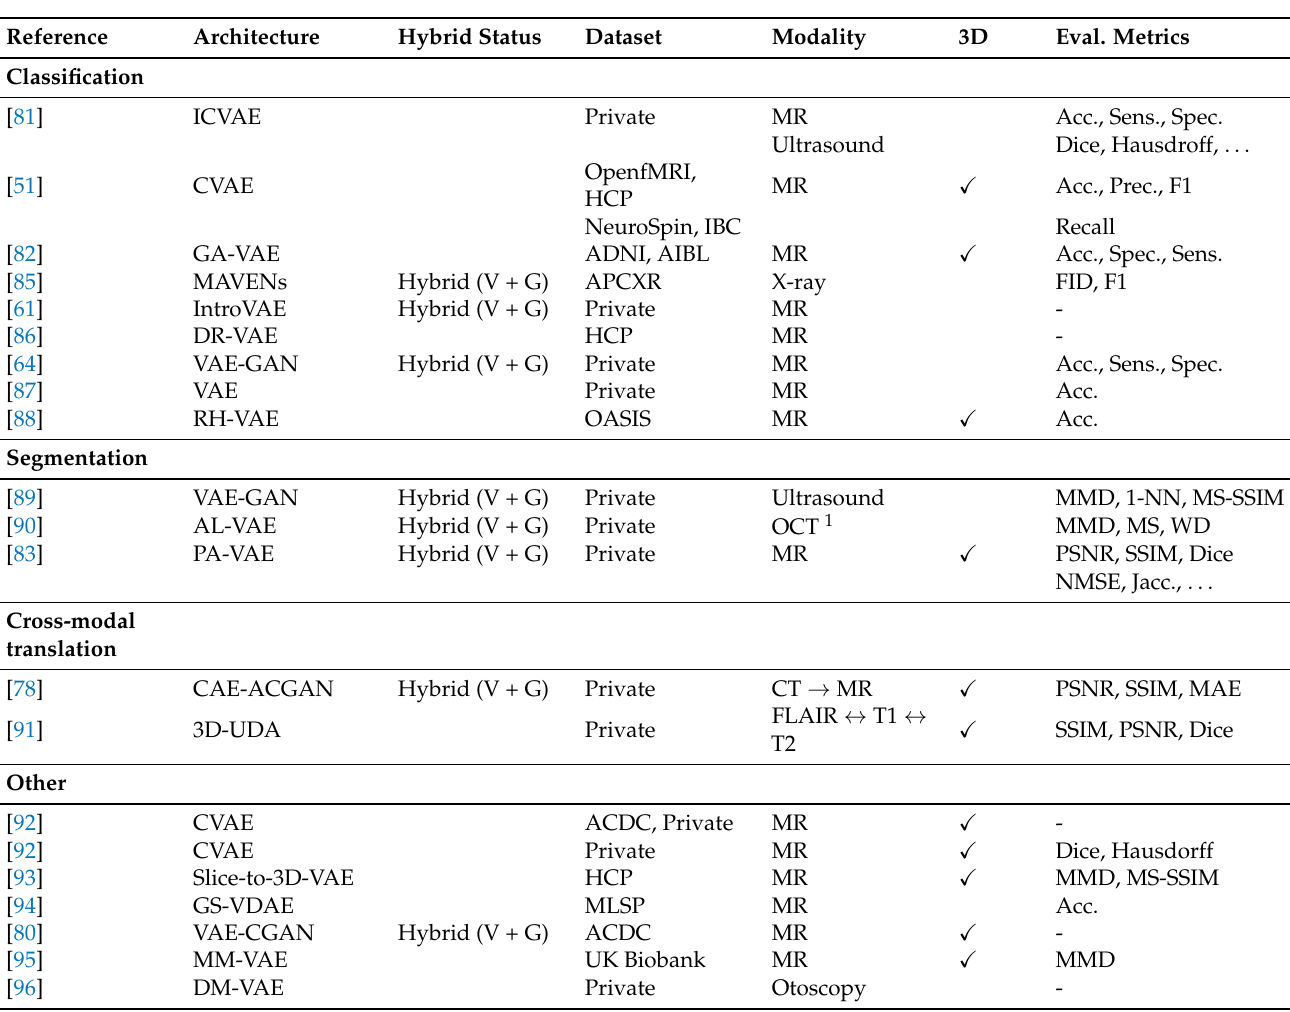
Table 2. Overview of VAE-based architectures for medical image augmentation, including hybrid status of architectures (if applicable), indicating the combination of VAEs and GANs used in each